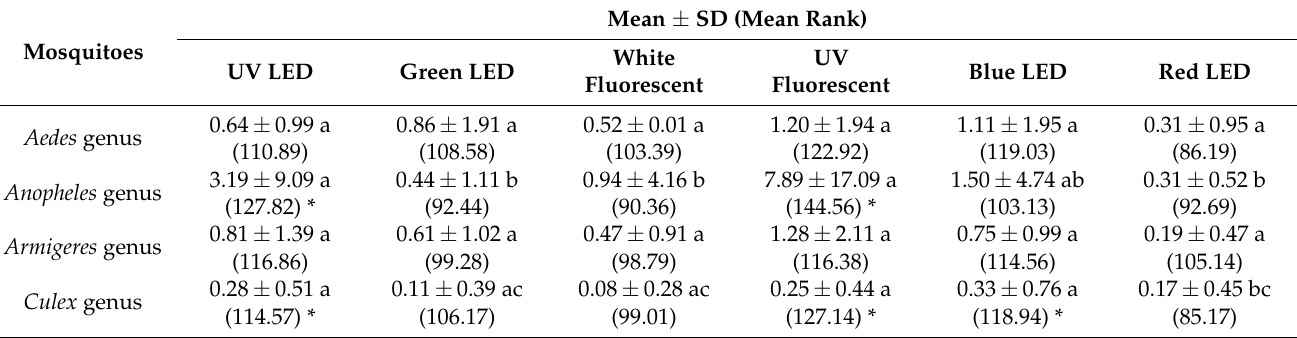
Table 3. Mean numbers and Kruskal–Wallis mean ranks of four mosquito genera collected during 36 trapping nights, using six different light source